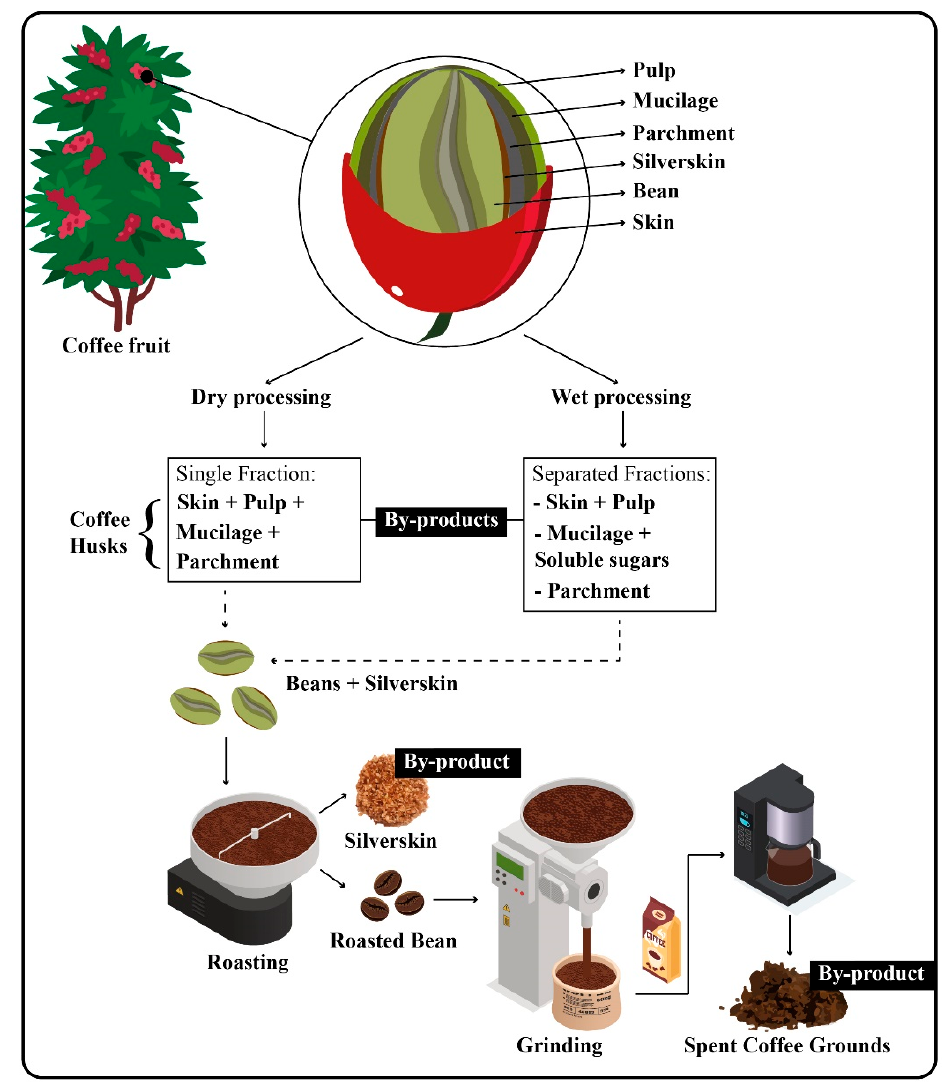
Figure 1. Coffee production and by ‐ products.